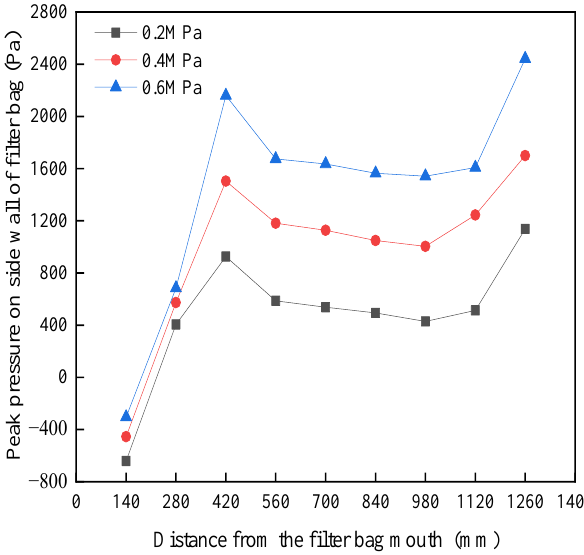
Figure 4. Peak side wall pressure of filter bag under different injection pressure. The high-pressure airflow from the nozzle was converted to power by passing through the straight tube at the top of the filter bag to form a low-pressure area, where the pressure was converted to power and a secondary air flow was induced. It can be observed from Figure 4 that, in terms of the overall distribution, the upper (420 mm) and bottom (1260 mm) filter bag side wall pressure was more variable, while the central and lower (560–1120 mm) areas were more uniform, showing a gradual reduction in the trend. This was mainly because, in the process of downward airflow, the induced airflow was first ejected from the induced flow tube and then rapidly expanded; the airflow was ob- structed by the filter bag wall and spread outwards, and the side wall was subjected to higher pressure, reaching a peak at the third measurement point, i.e., 420 mm from the filter bag mouth. Then the airflow expanded and overflowed and, with the loss of dy- namic pressure, the side wall pressure of the filter bag began to fall. Finally, as the bottom